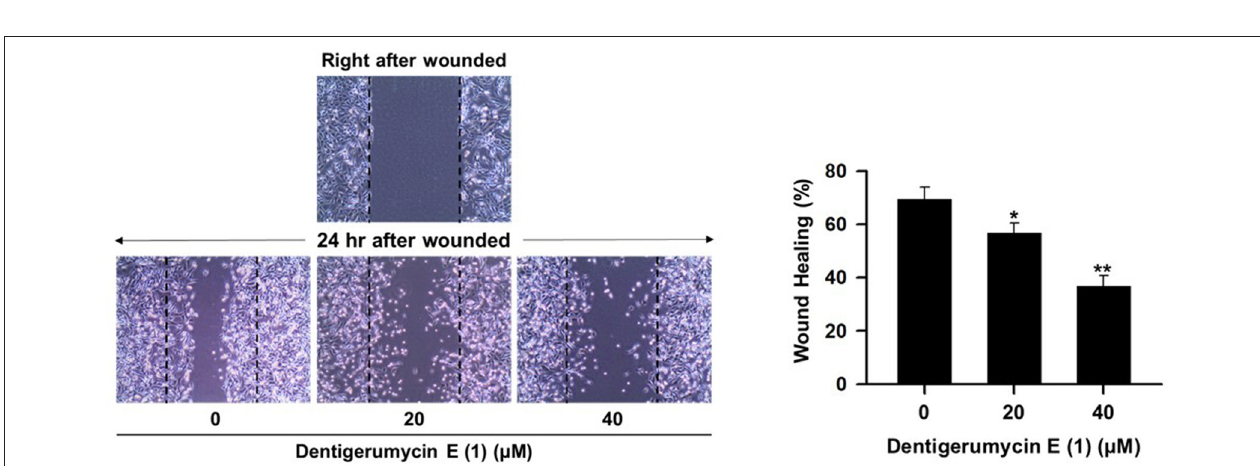
FIGURE 7 | Dentigerumycin E ( 1 ) suppresses cell migration of the metastatic human breast cancer cell line (MDA-MB-231) in the wound healing assay. The data are represented as the means ± SD from three independent experiments: * p < 0.05, ** p < 0.01.